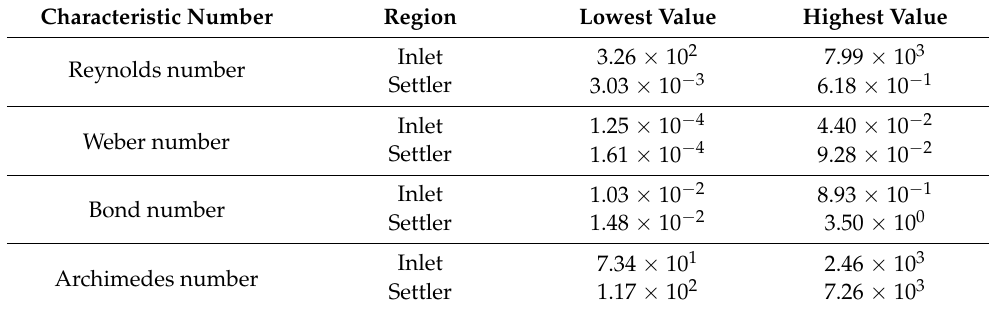
Table 1. Representation of dimensionless ratios from simulations of a horizontal continuous settler.